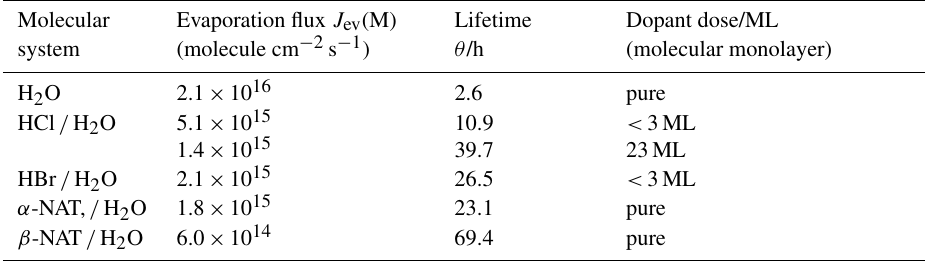
Table 5. Atmospheric lifetimes of various 20µm diameter ice particles at 190K calculated using the measured absolute rate of H 2 O evapo- ration of corresponding ice particles ∗